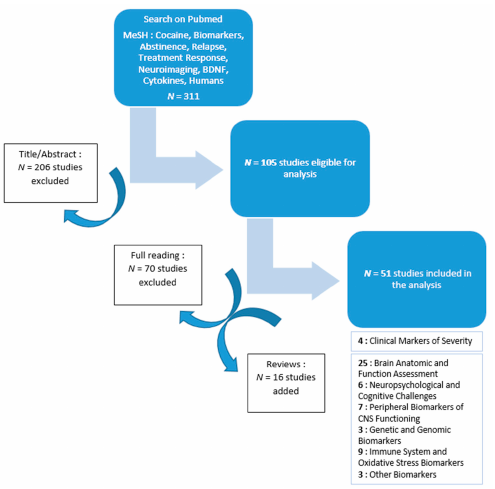
Figure 1. Flow-chart of the article selection process.